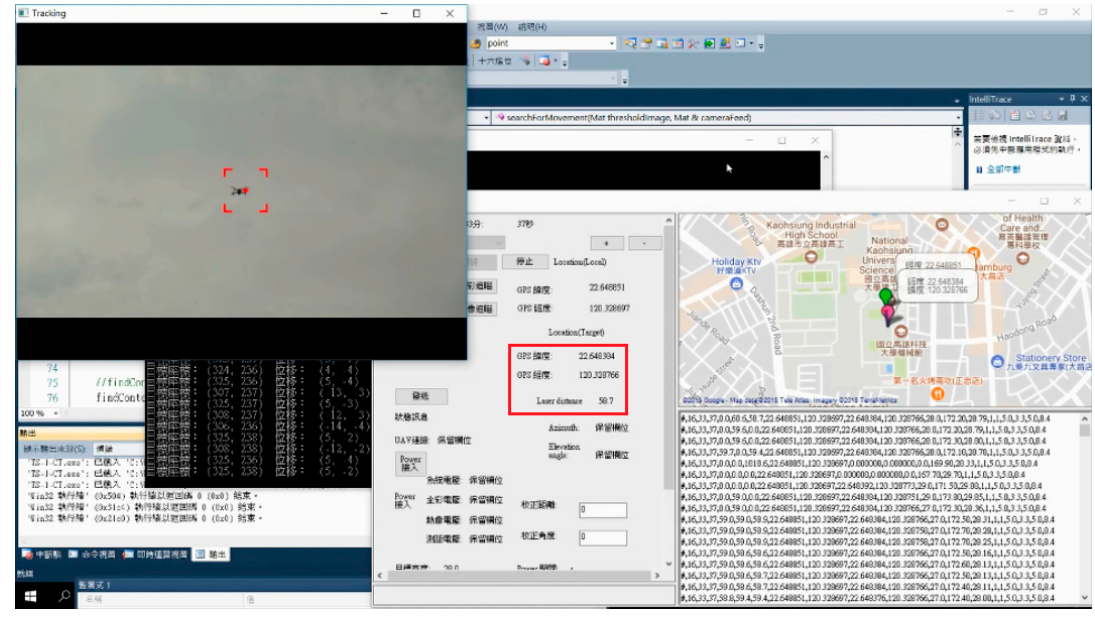
Figure 17. Test results of the full-color tracing interface. Appl. Sci. 2019 , 9 , x FOR PEER REVIEW